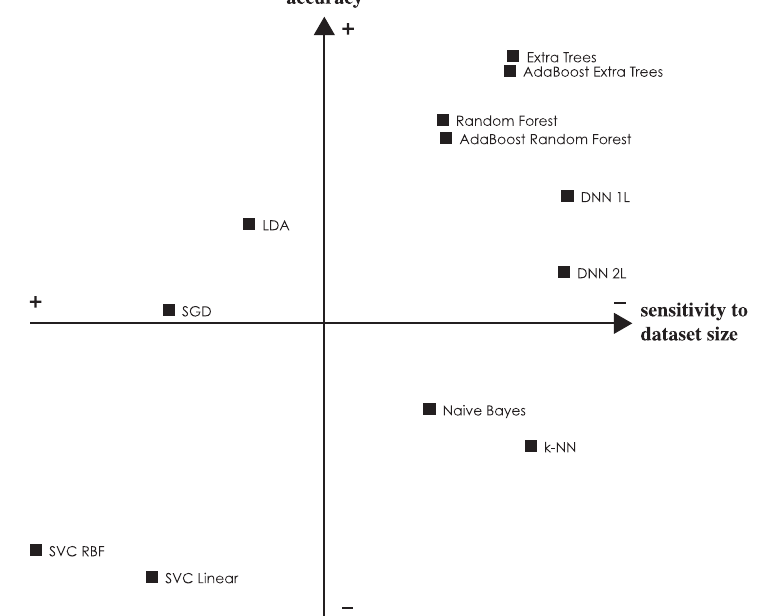
Figure 10. Concept map showing the relative performance of each classifier both in terms of accuracy and sensitivity to the dataset size. In the former metric, more (up) is better, while in the latter, less (right) is better, as lower values represent less variance in the accuracy when reducing the dataset